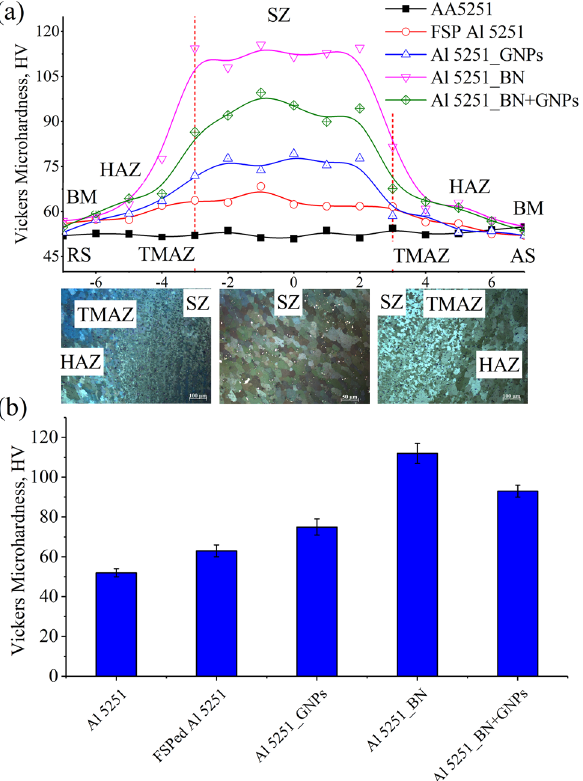
Figure 8: ( a ) Vickers microhardness pro fi le and ( b ) the average Vickers microhardness in the BM and the SZ.